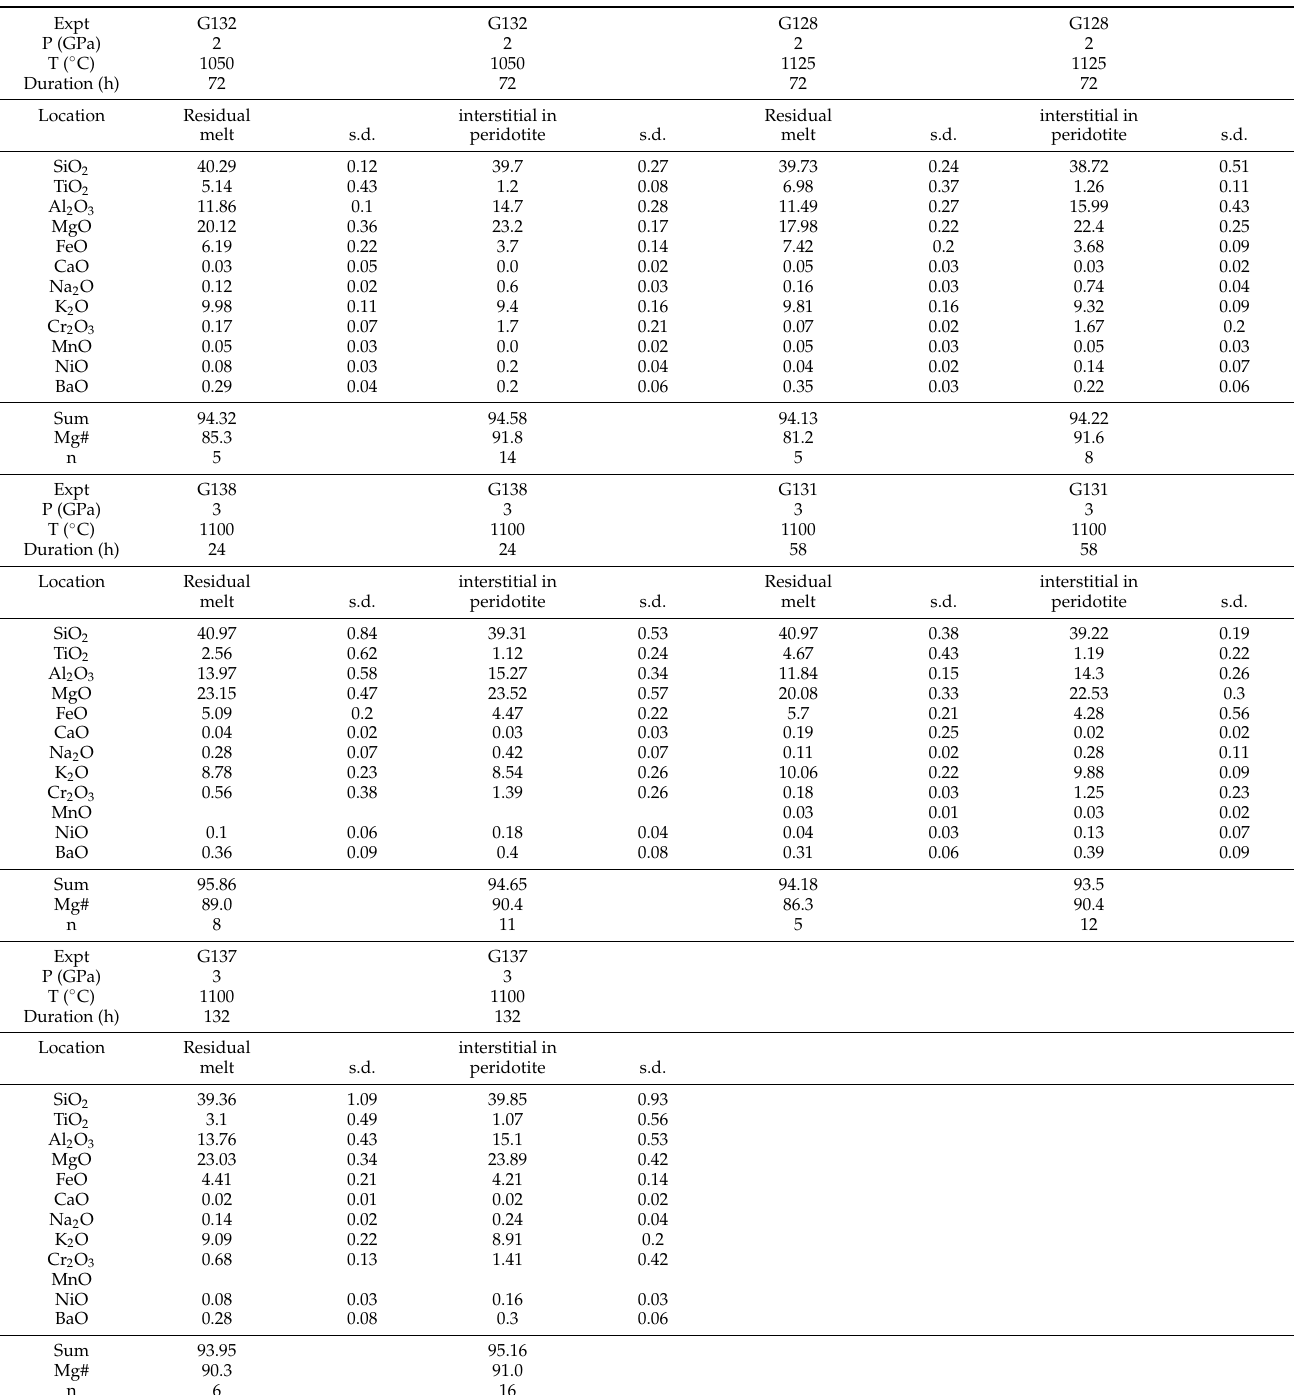
Table 3. Phlogopite compositions in dynamic metasomatism